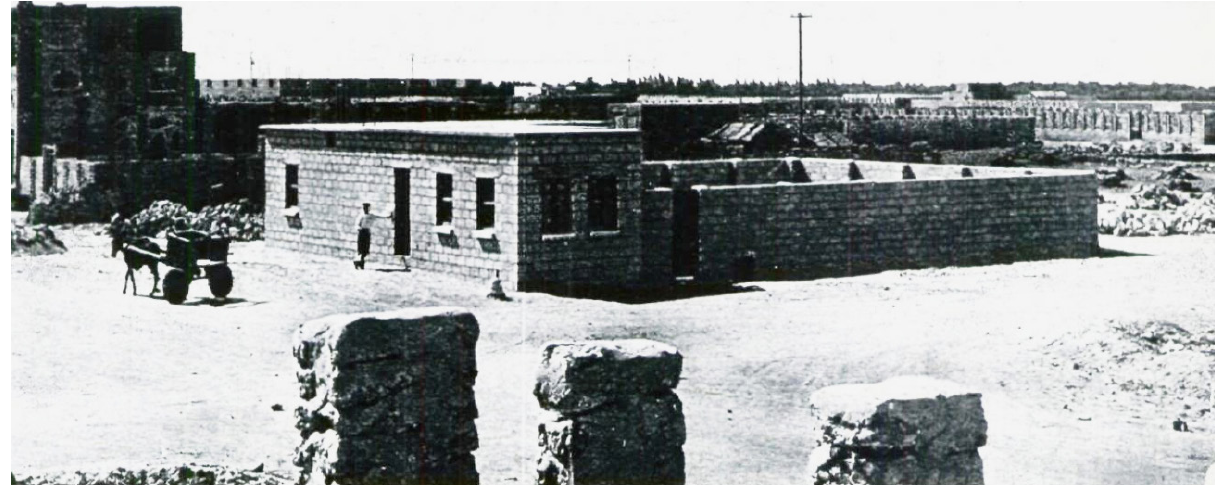
Aramco’s first houses in the early 1950s. Source: Saudi